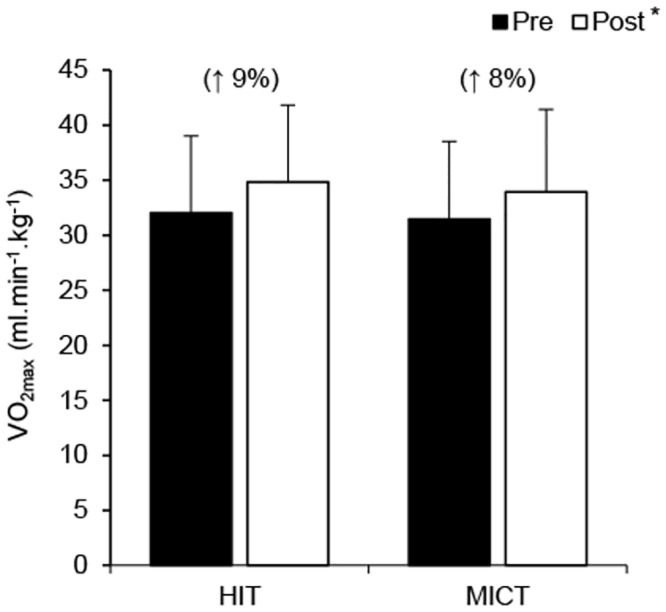
VO2max response to HIT and MICT.Values are presented as means ± SD. Values in parentheses represent the mean percentage change from pre-training. *Main training effect (p<0.05).